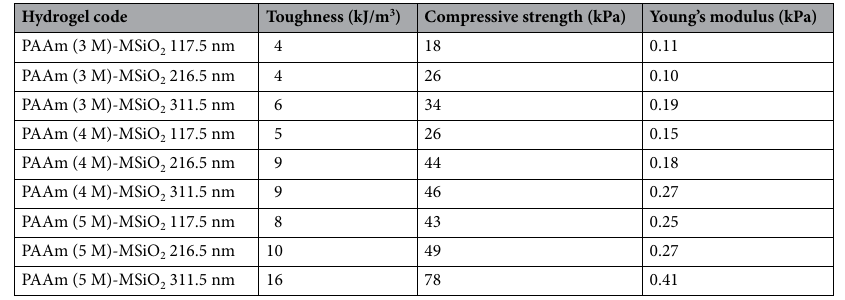
Table 6. Comparison of compressive strength of PAAm-MSiO 2 hydrogels prepared by varying particle sizes of MSiO 2 (117.5 nm, 216.5 nm, and 311.5